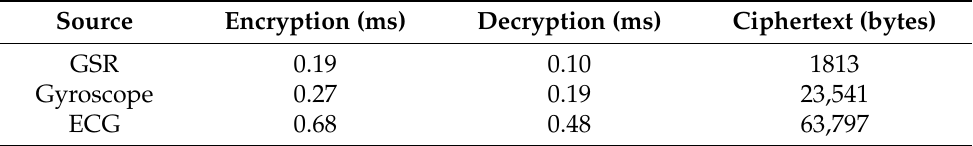
Table 7. Realtime Sensor’s Data